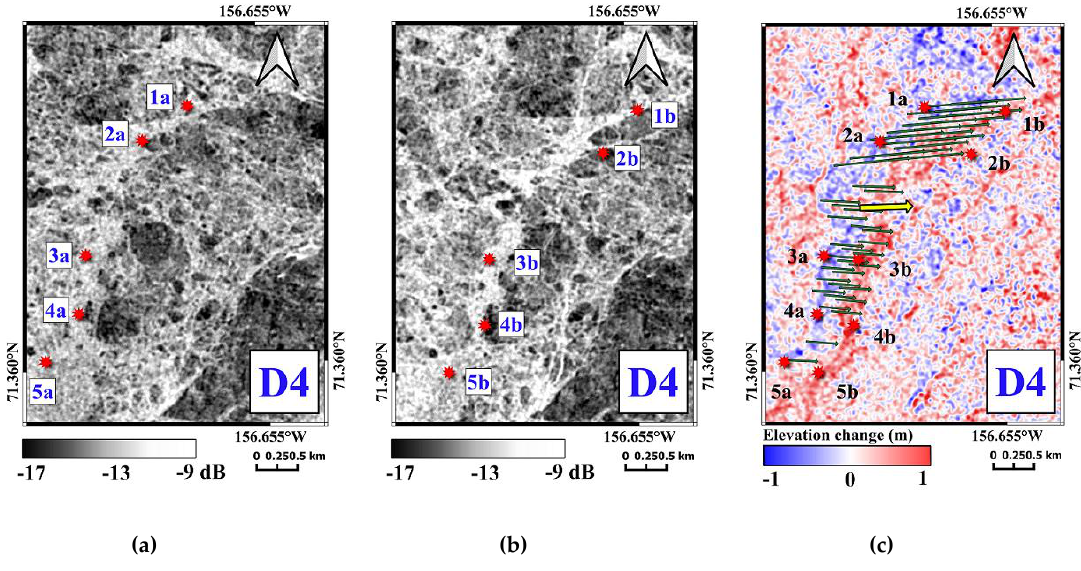
Figure 10. Displacement D4: SAR backscatter intensity on 13 Jan ( a ) and 24 Jan 2012 ( b ). The HDM is displayed in ( c ) with individual displacement vectors in green and average displacement vector in yellow. Control points 1a–5a and 1b–5b represent ridge features that can be recognized before and after the displacement.